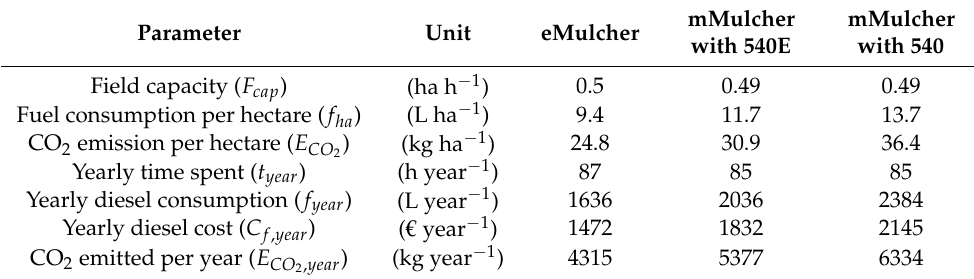
Table 15. Operational and environmental indexes with the mulchers on SimVin. These results were calculated supposing a field area to work equal to 174